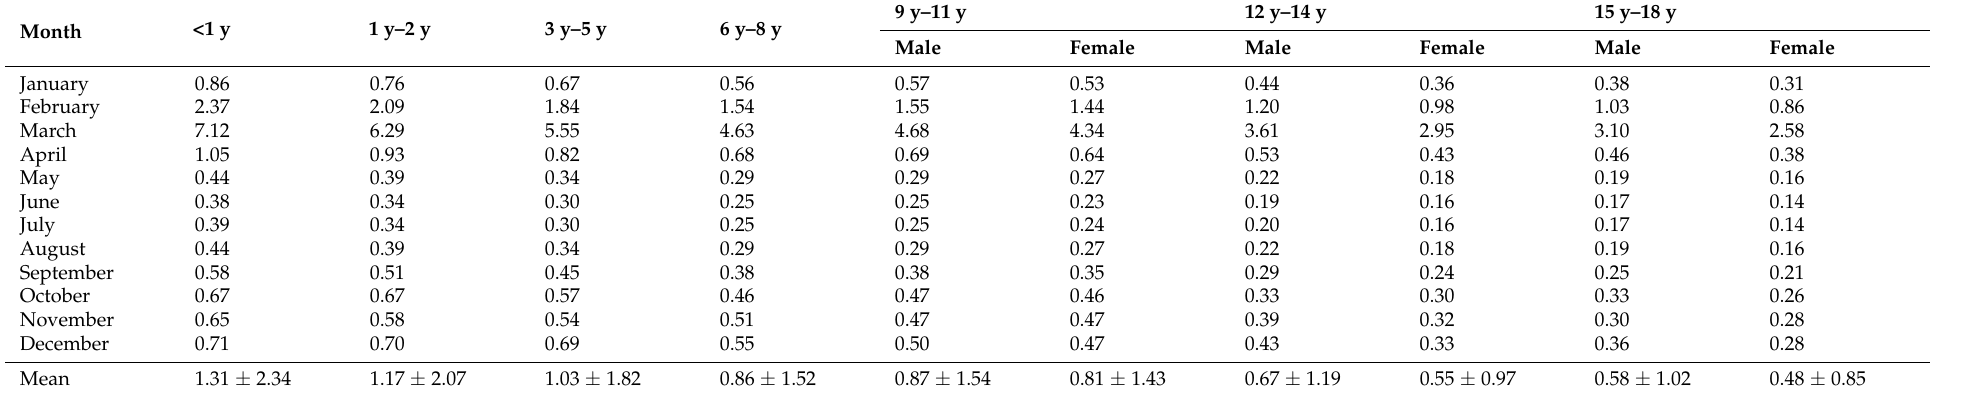
Table 5. Minimum of the monthly means of the HQ related to PM 2.5 according to the different age groups of children during 2020–2029.